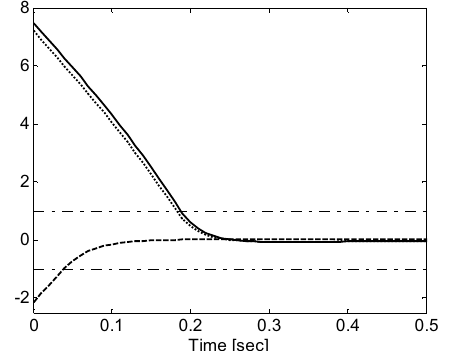
Fig. 3. Sliding hyperplane variables, s i ( t ) , versus time. ---- s 1 , — s 2 , · · · · · s 3 , – · – · boundary layer.